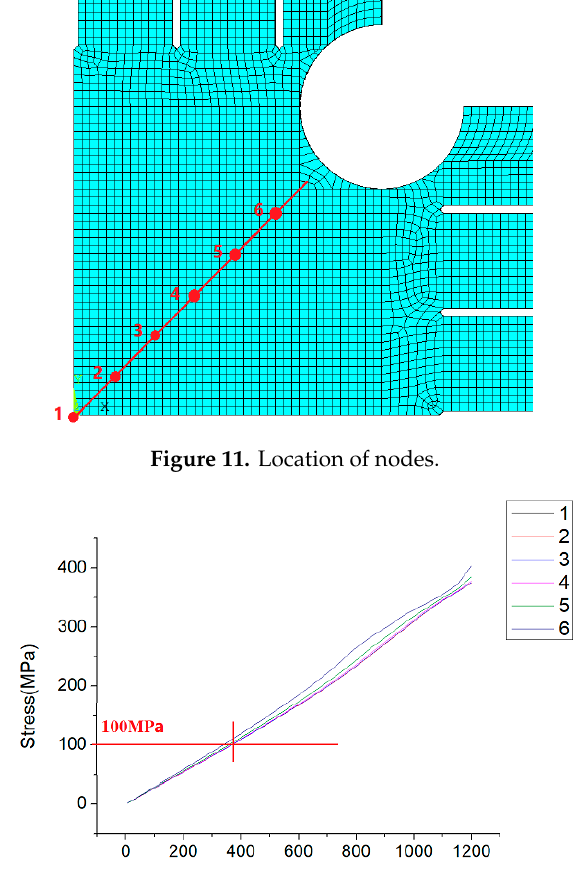
Figure 12. Mises stress-load curves of six nodes of the specimen.